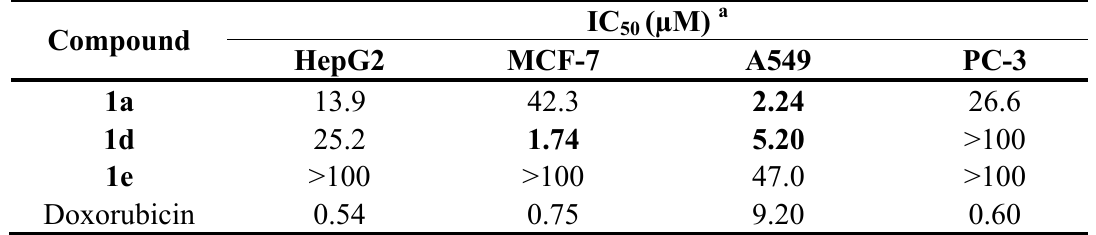
Table 1. The anti-proliferation activities of compounds 1a , 1d and 1e against various cancer cell